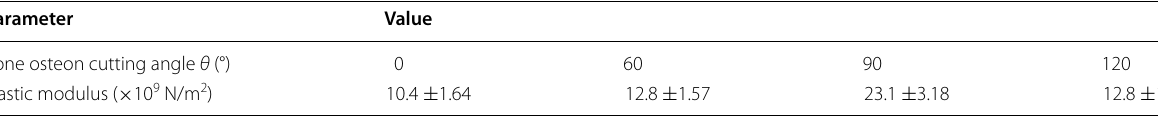
Table 2 Elastic modulus in different bone osteon orientations [28]